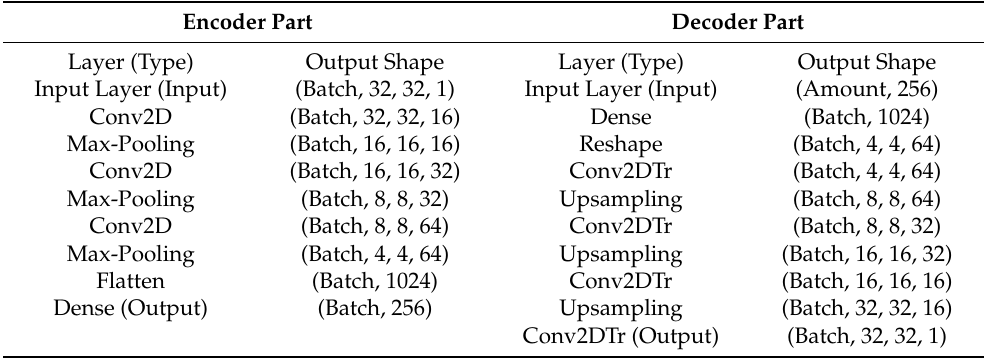
Table 2. Autoencoder